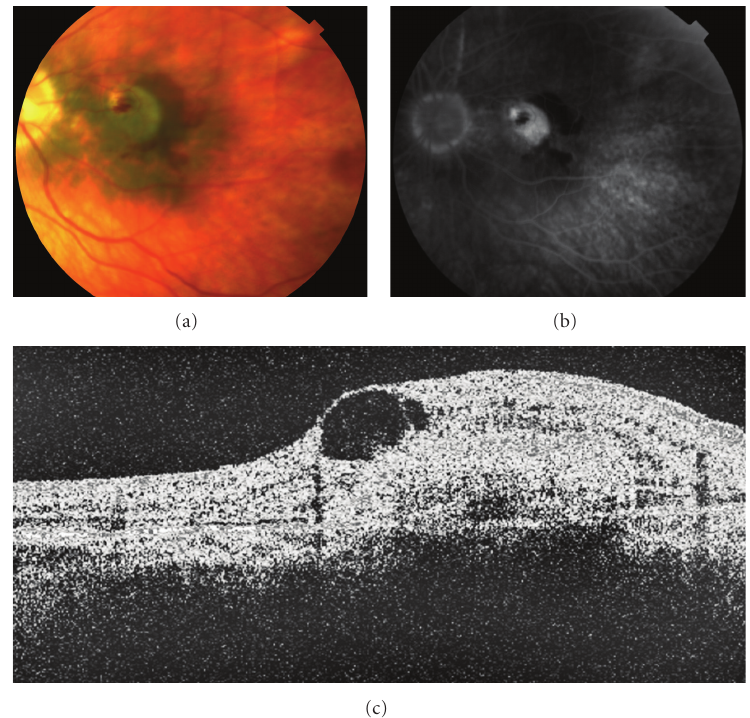
Figure 3: Images of the left eye 12 months after the third ranibizumab injection. (a) Color fundus photo shows retinal hemorrhage surrounding a CNVM, hyperpigmented macular RPE, and peripheral RPE hypopigmentation. (b) Fluorescein angiography shows a CNVM and hyperfluorescent, peripheral RPE changes. (c) Optical coherence tomography shows a parafoveal CNVM with a significantly increased amount of intraretinal fluid (compare with Figure